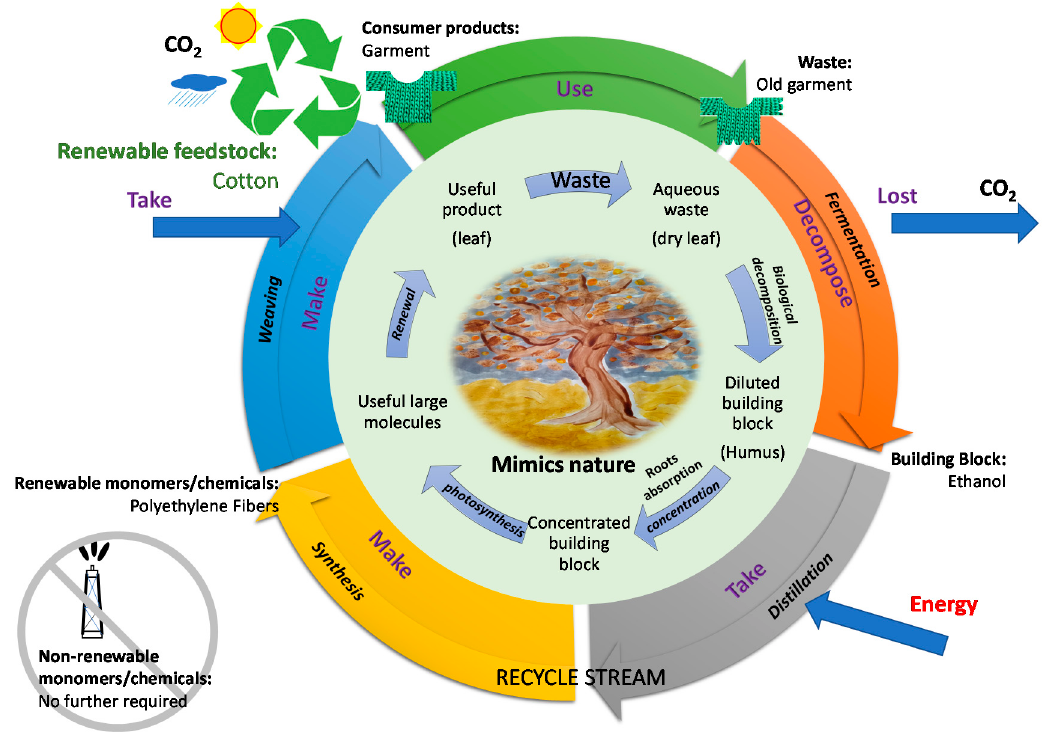
Figure 1. Circular economy as a mimic of natural processes.